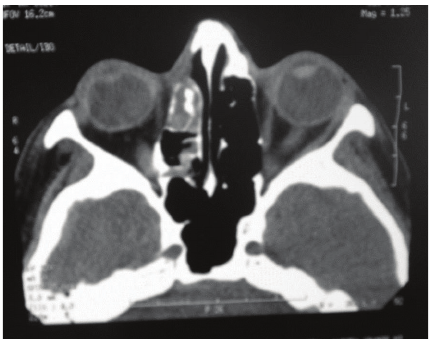
Figure 5: CT section of the